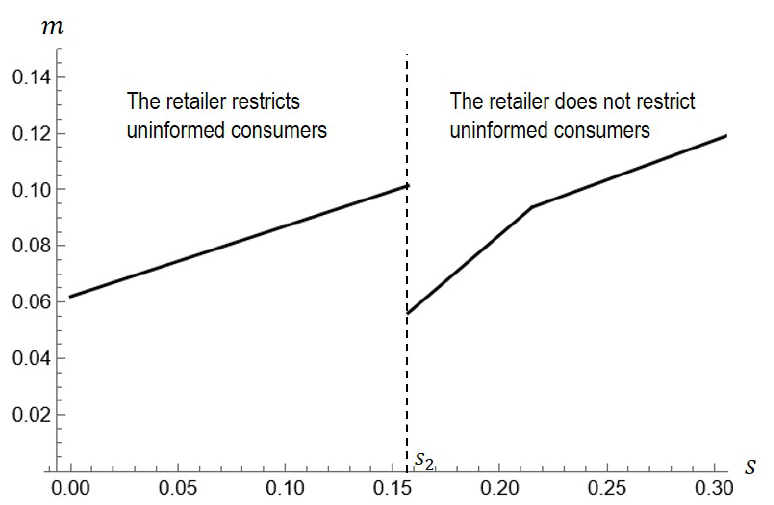
Figure 3. The optimal premium changes in scenario NR ( c = 0.4, θ = 0.6, λ l = 0.4, λ h = 0.5, β = 2, h = 0.048, k =